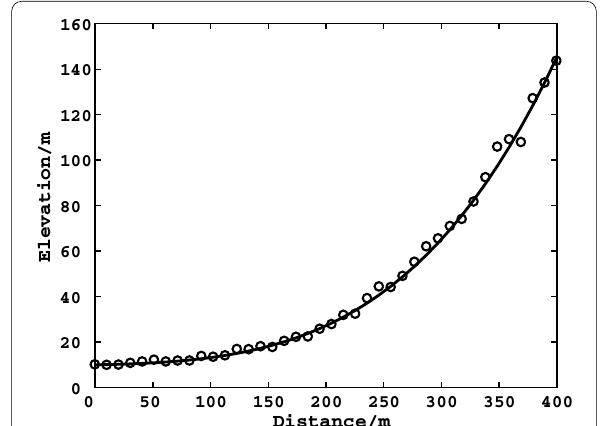
Fig. 5 Elevations of the ground elevation points before and after disturbance by MAAMREs in the second example